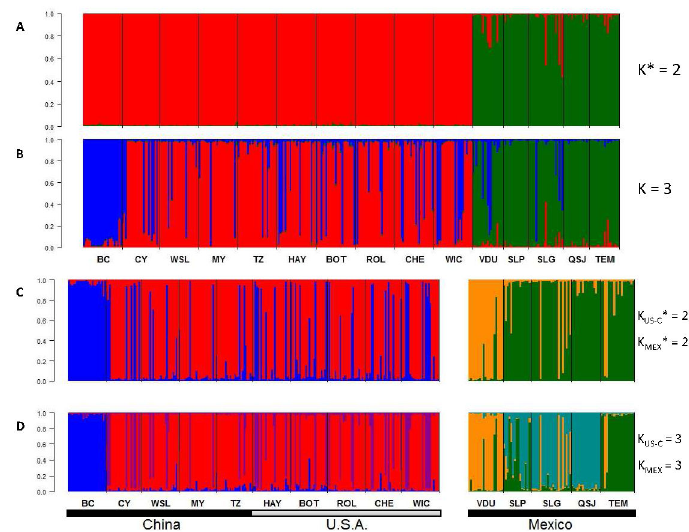
Figure 4. Posterior probability of cluster assignment in nested InStruct analyses of 329 Solanum rostratum individuals genotyped at 10 microsatellite loci across 15 populations in three geographic regions: Mexico, the U.S.A. and China. Each bar represents a single individual with populations separated by black lines and arranged from North to South within each region. Panel A depicts the uppermost level of population structure across regions. The optimal number of clusters ( K* = 2) was calculated using Evanno’s et al. [31] ∆K statistic. For illustration, panel B shows the assignment probabilities for K = 3. Panel C represent two separate analyses of either U.S.A./Chinese or Mexican populations; the optimal number of clusters [31] in each of these separate analyses was K * = K * = 2. Panel D , shows assignment probabilities for K = 3, for each separate analysis. US-C US-C